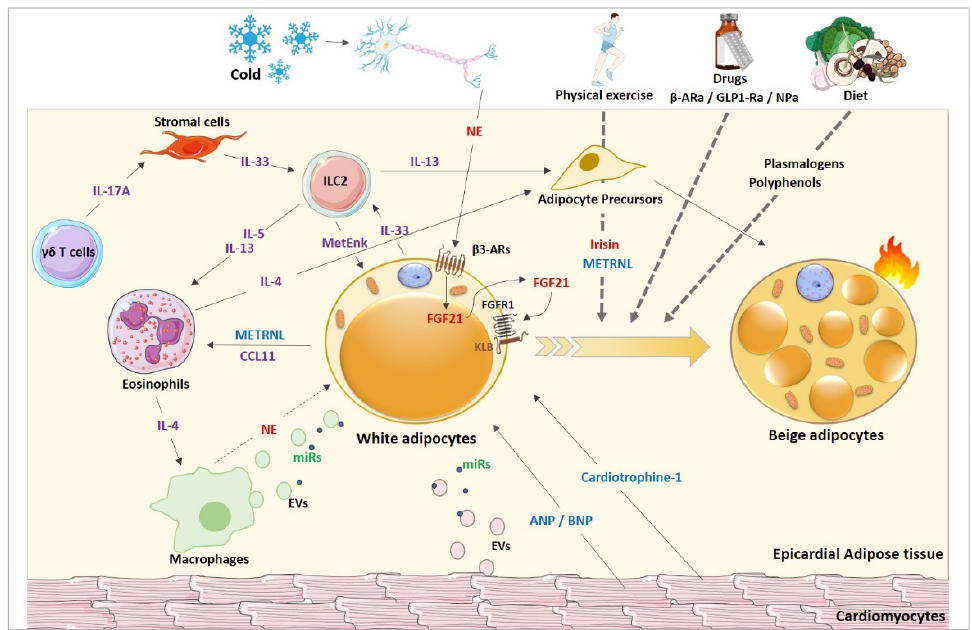
Figure 3. Potential factors involved in the EAT browning. Putative mechanisms based on work realized in adipose tissue in general. Environmental factors such as cold exposure, physical exercise, pharmacological treatments and dietary are implicated in browning of white adipocytes but the mechanisms underlying are not yet well established (dotted arrows). Inter-cellular communication factors involving cytokines/chemokines (purple), myokines (blue), hormones (red) and miRs (green) are known to be involved in WAT browning. EVs: extracellular vesicles; β -Ara: β -adrenergic receptor agonists; GLP1-Ra: GLP1- receptor agonists; NPa natriuretic peptide agonists; METRNL: Meteorin Like; MetEnk: methionine enkephalin, NE: norepinephrine, FGF21: fibroblast growth factor 21; FGFR1: FGF receptor 1; KLB: coreceptor Beta-klotho.